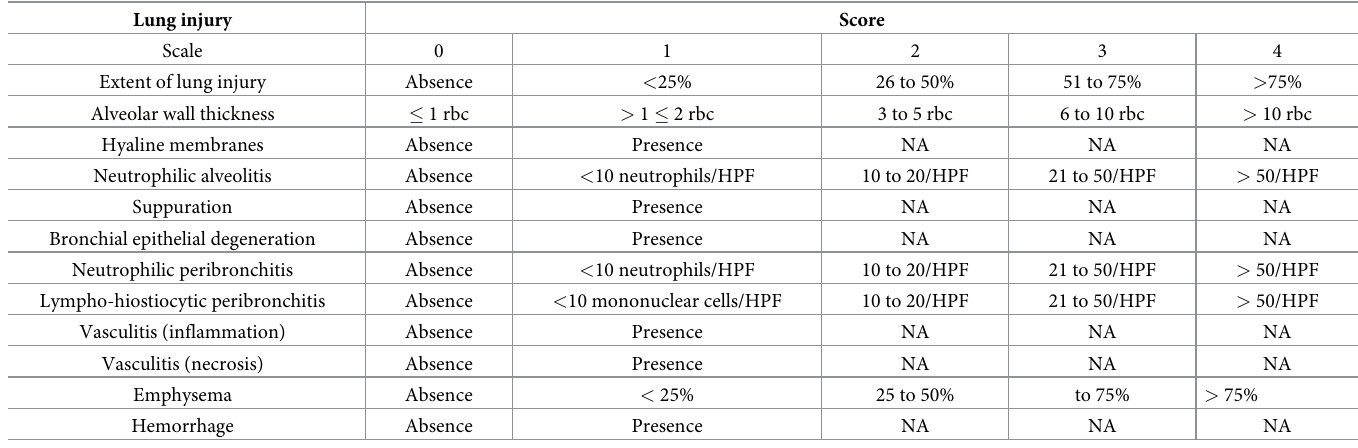
compared to controls (Fig 2A). An increased number of neutrophils, alveolar macrophages (AM) and dendritic cells (DC) (p < 0.05) in the BAL were reported of infected CS-exposed mice compared to uninfected mice, whereas neutrophils and DC were higher in the lungs (Figs 1D and S2). This increase was consistent at 48h p.i. for the total cell number and the neu- trophil count (S2C Fig, p < 0.01). After treatment with FliC, the total cell number was reduced in both control and CS-exposed mice infected with NTHi. This was related in CS-exposed mice to a lower number of neutrophils in the BAL, and a trend for AM and DC. DC activation evaluated in the airways by the expression of CD86 and the MHC molecule I-Ab was not mod- ulated in CS-exposed mice treated with FliC (S2B and S2D Fig). Regarding lymphocytes, we showed a significantly higher recruitment of both NKT and T cells in the BAL (p < 0.05) and the lungs upon infection of controls and CS-exposed mice (Figs 1D and S2A). Treatment with Table 4. Lung injury scoring